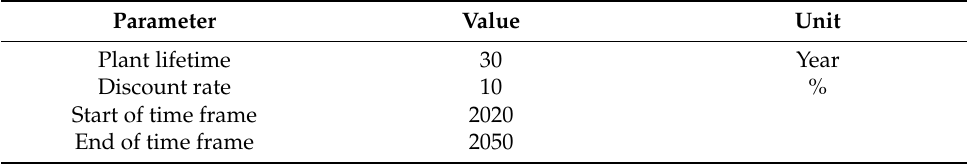
Table 2. Economic parameters to estimate annual investment